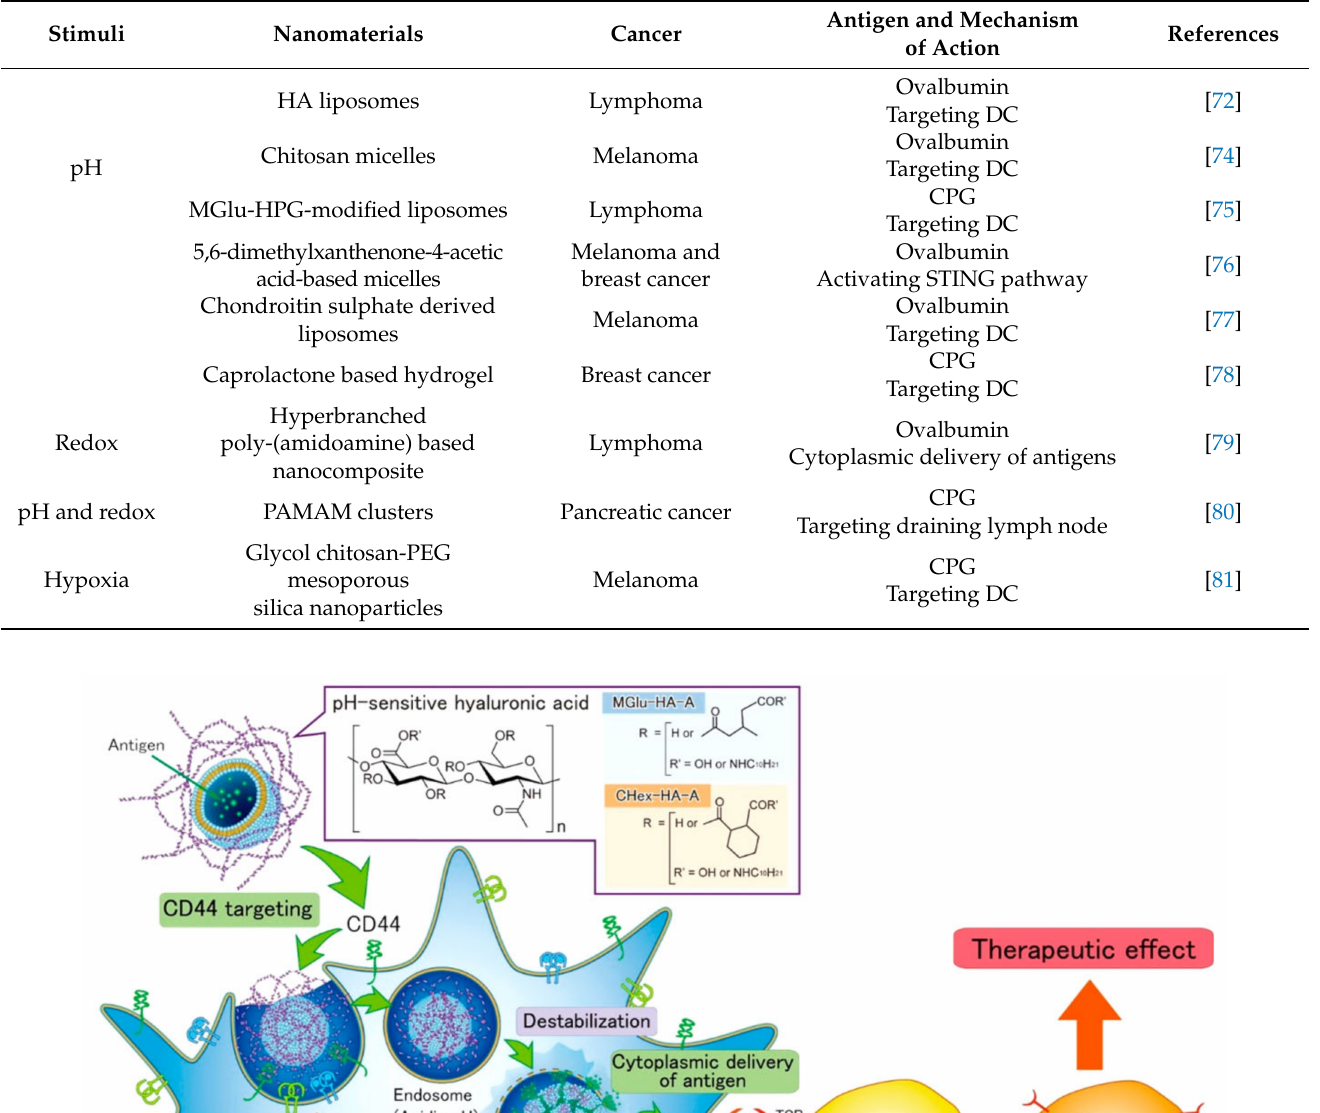
Table 3. Endogenous stimuli-based polymer nanoparticles for delivery of antigens.